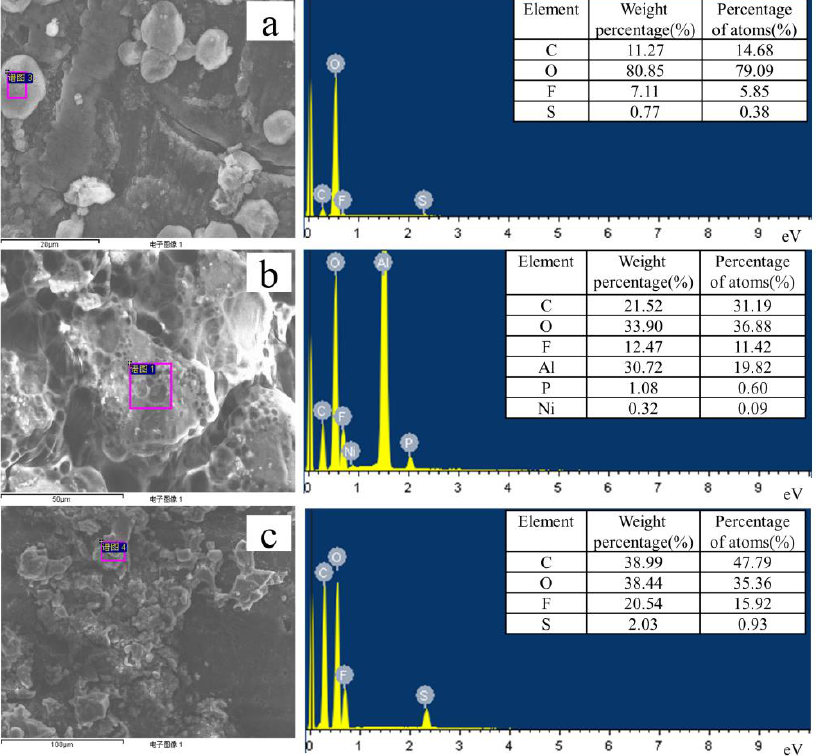
Figure 8. EDS tests results of lithium electrodes: ( a ) In Li|GPE-80|Li cell after 1000 cycles, ( b ) in liquid electrolyte after 80 cycles, and ( c ) in a GPE-80 full cell after 80 cycles.